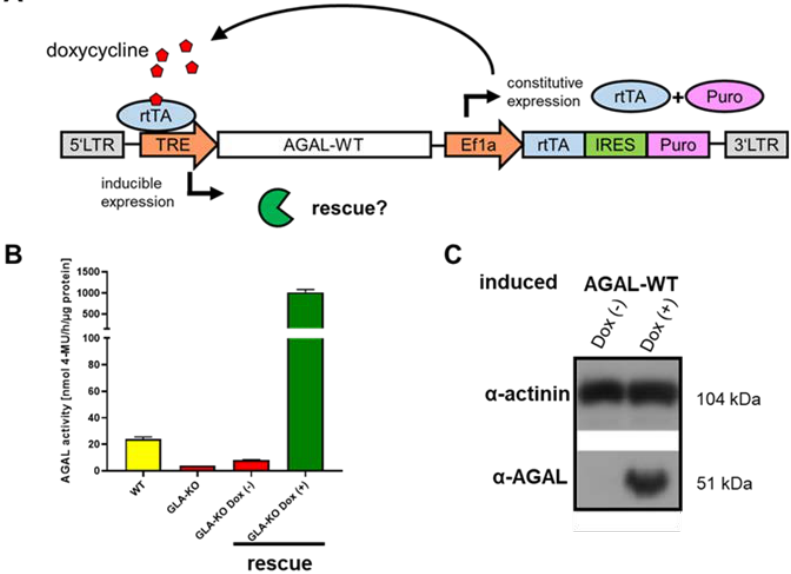
Figure 2. Generation of an inducible AGAL and mutant rescue in Fabry podocytes. ( A ) Schematic overview of the doxycycline inducible pINDUCER construct (tet on—tet off) driving wild-type AGAL expression after stable lentiviral-mediated genomic insertion. ( B ) AGAL activities in wild- type, AGAL-deficient and lentiviral-mediated transfected podocytes with and without doxycycline induction. ( C ) Western blot analysis of AGAL expression in lentiviral-mediated rescued wild-type doxycycline-induced podocytes. AGAL: α -galactosidase A, Dox (-): without doxycycline, Dox (+): with doxycycline, Ef1a: elongation factor 1 alpha, IRES: internal ribosomal entry site, LTR: long terminal repeat, Puro: puromycin resistance, rtTA: reverse tetracycline-controlled transactivator, TRE: tetracycline response element, WT: